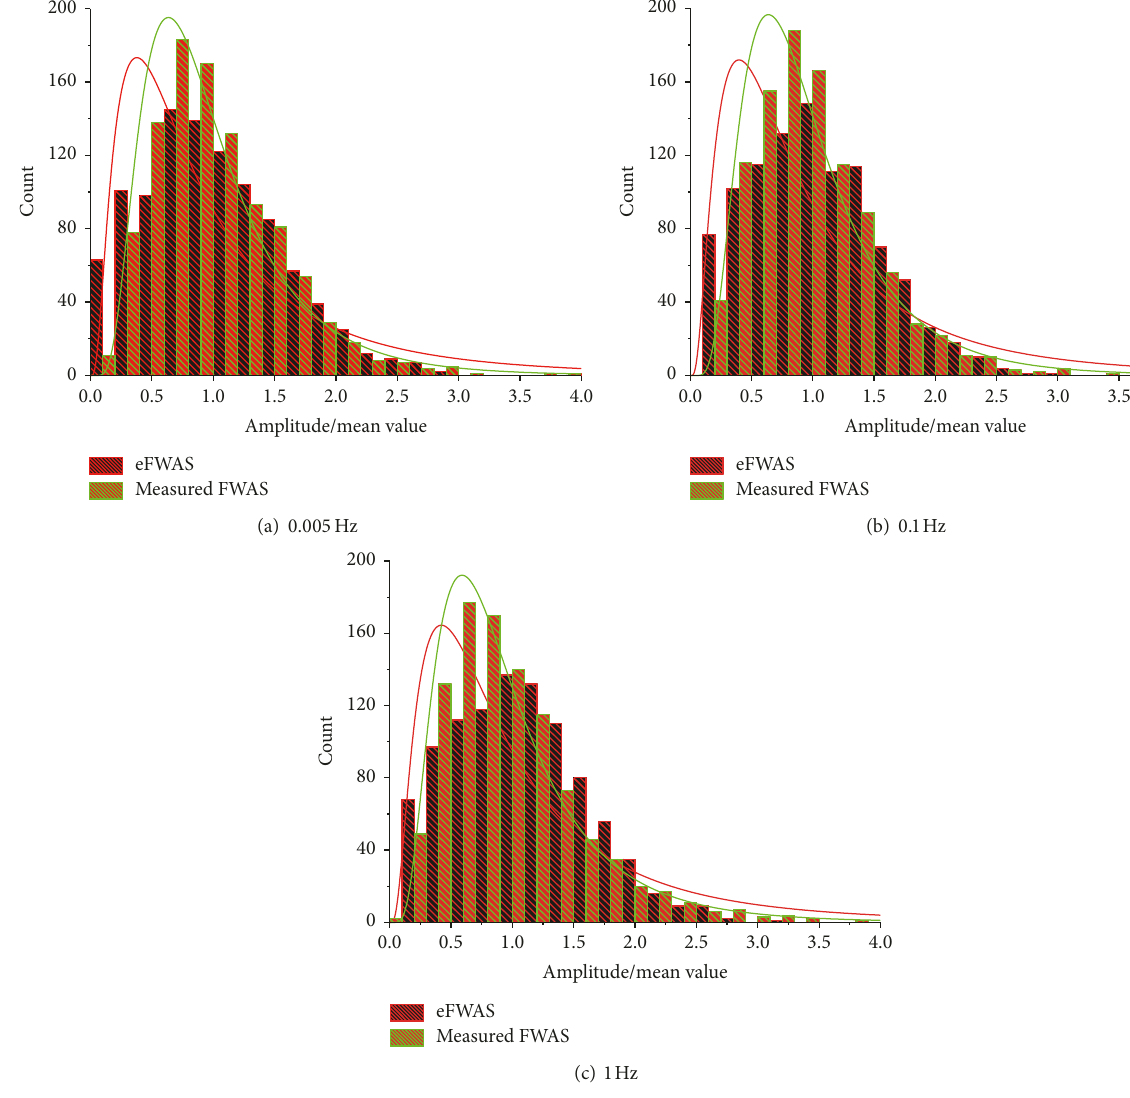
Figure 12: Amplitude distribution at certain